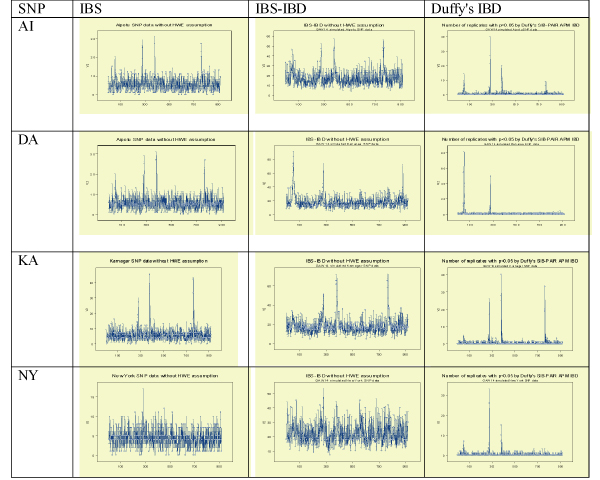
The number of significant (0.05 level) replicates over the SNPs.